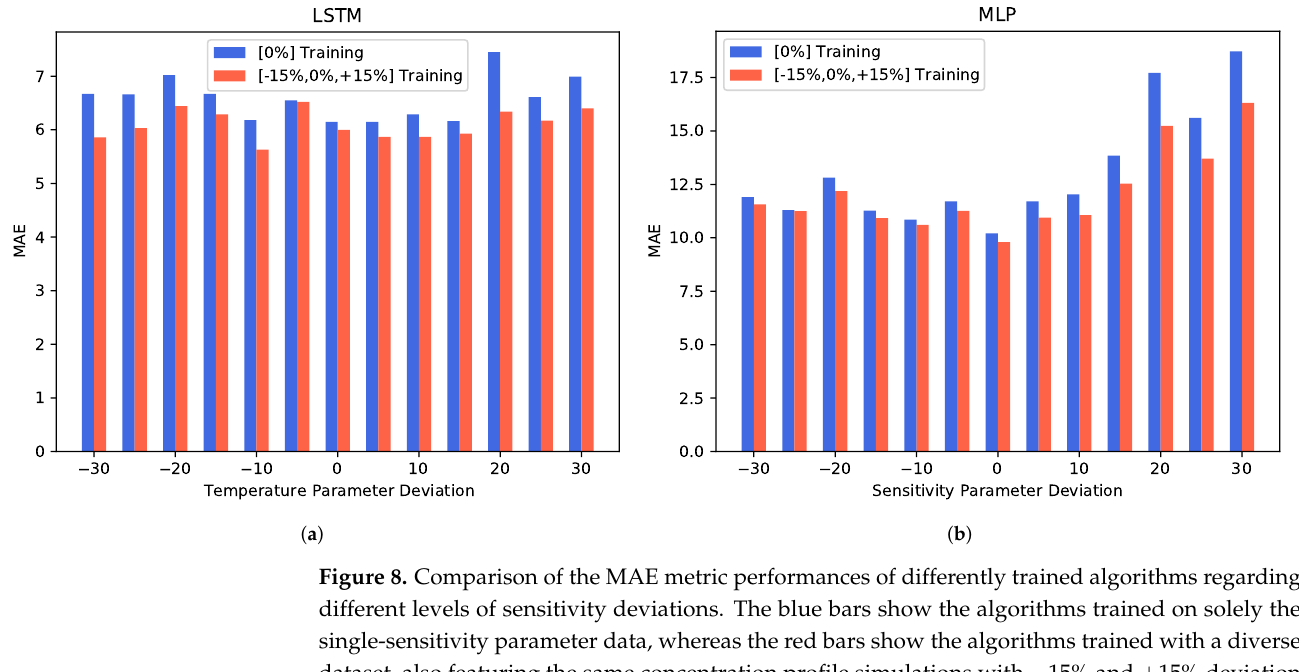
Figure 8. Comparison of the MAE metric performances of differently trained algorithms regarding different levels of sensitivity deviations. The blue bars show the algorithms trained on solely the single-sensitivity parameter data, whereas the red bars show the algorithms trained with a diverse dataset, also featuring the same concentration profile simulations with − 15% and + 15% deviation from the standard sensitivity parameter. ( a ) shows the LSTM prediction performance and ( b ) the MLP prediction